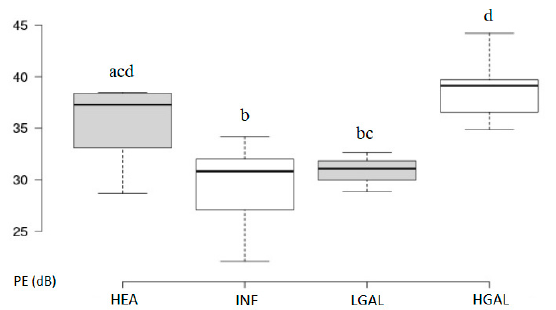
Figure 8. Box and whisker plot of the time to fall (TO) for healthy (HEA), inflammatory (INF), low-grade alimentary lymphoma (LGAL) and high-grade alimentary lymphoma (HGAL). a,b Values with different superscript letters differ significantly ( p < 0.05).